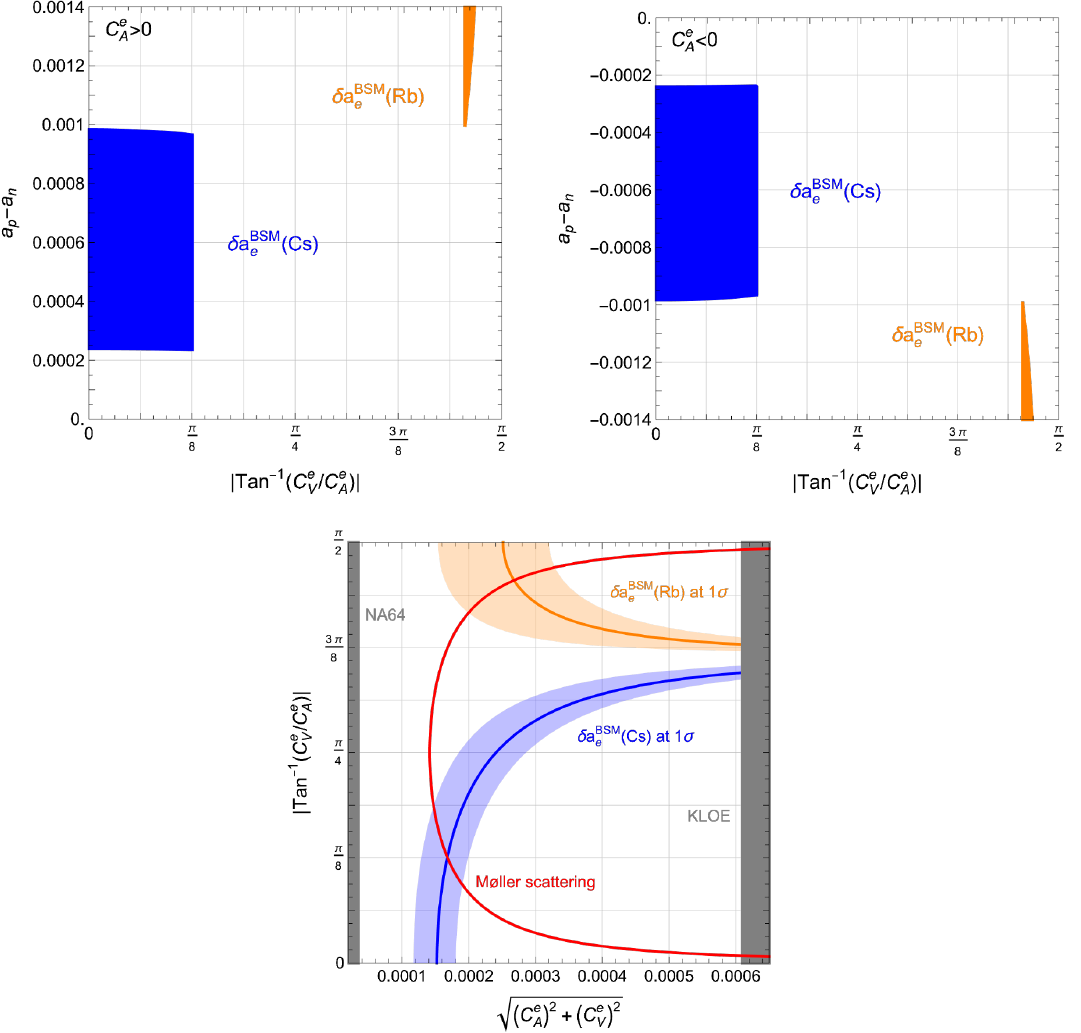
Figure 6 . Upper panels: Values of the isovector nucleon axial coupling a p − a n able to explain the KTeV anomaly at 1 σ varying the ratio of vector and axial electron coupling for the two distinct cases C e > 0 and C e < 0 . Lower panel: Bounds on the vector and axial couplings of the electron A A to a spin-1 boson with mass m 17 MeV. The gray regions are excluded by NA64 and KLOE X ∼ searches, while the region inside the red contour is excluded by Møller scattering. Here we assume BR( X → e + e − ) = 1